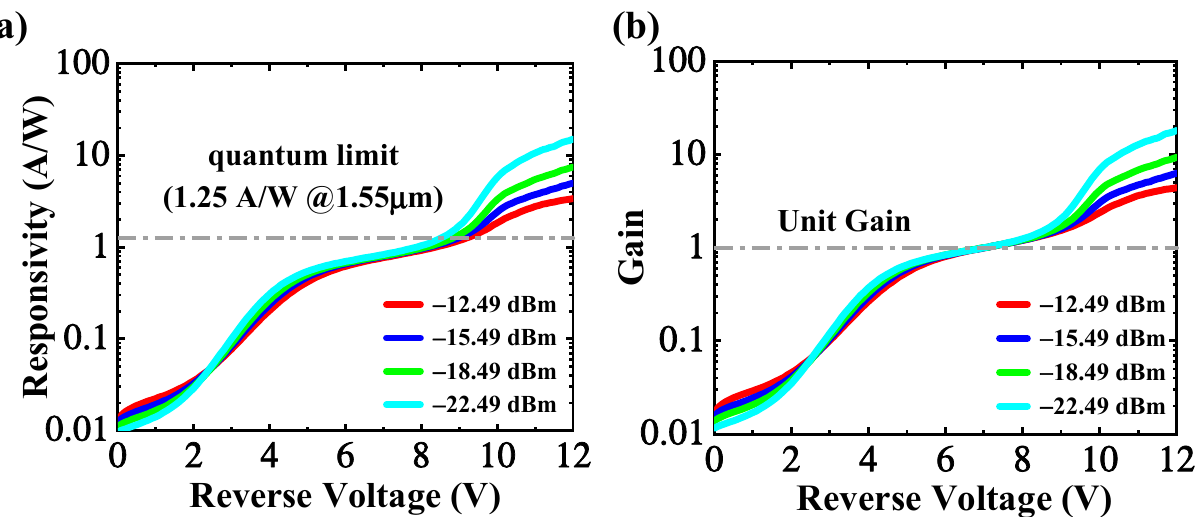
Figure 7. ( a ) The extracted responsivity is the function of the reverse voltage (the inset is the responsivity at low voltage); ( b ) The extracted multiplication gain is the function of the reverse voltage.